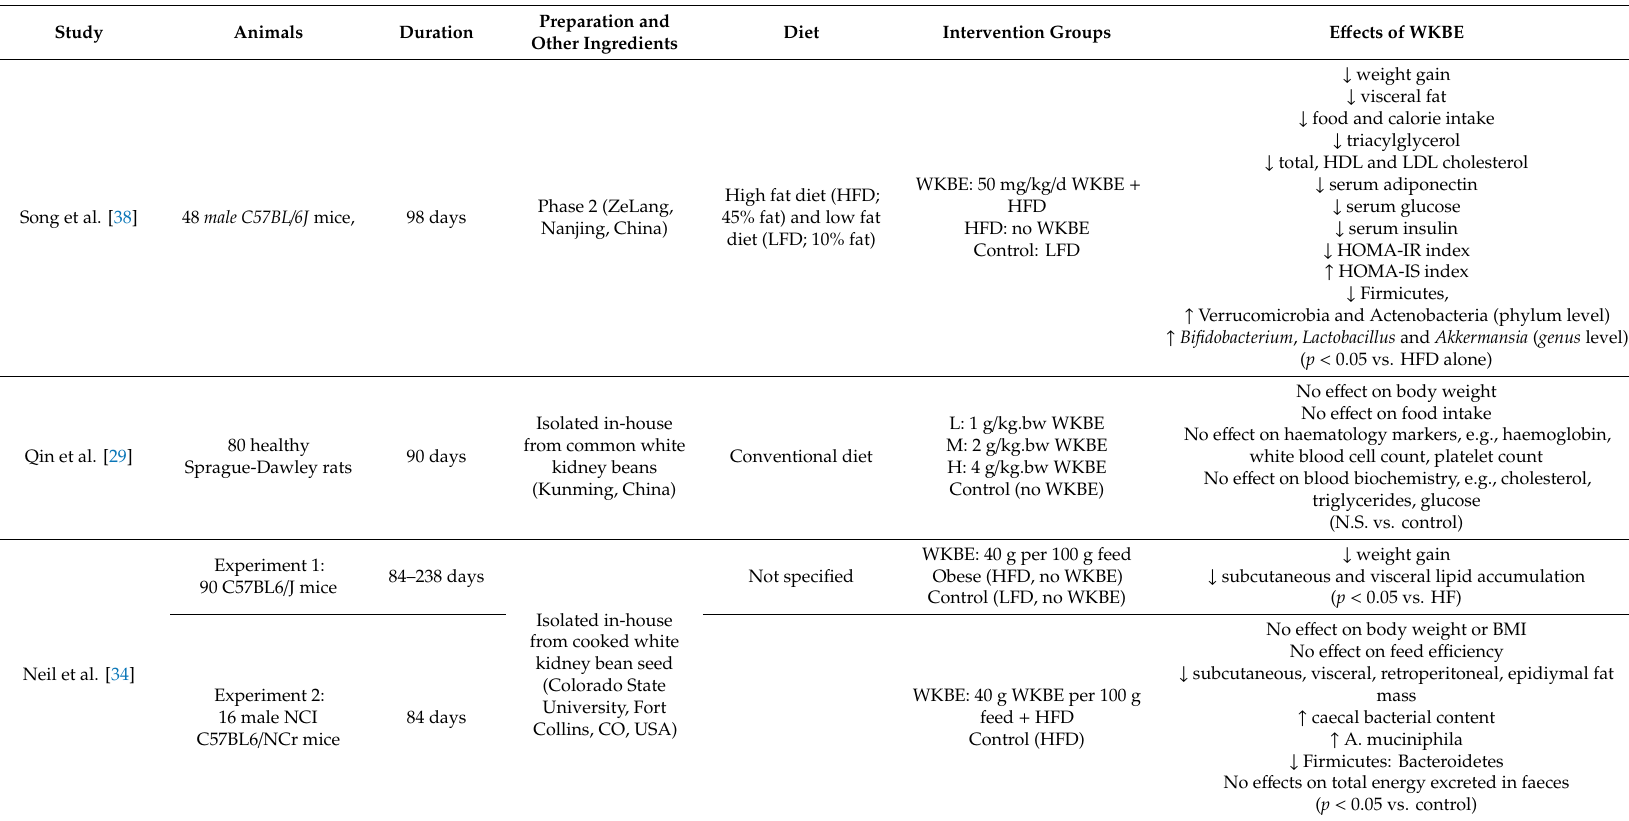
Table 1. Animal studies investigating the e ff ects of WKBE on body composition, metabolic risk factors and the gut microbiota. Study